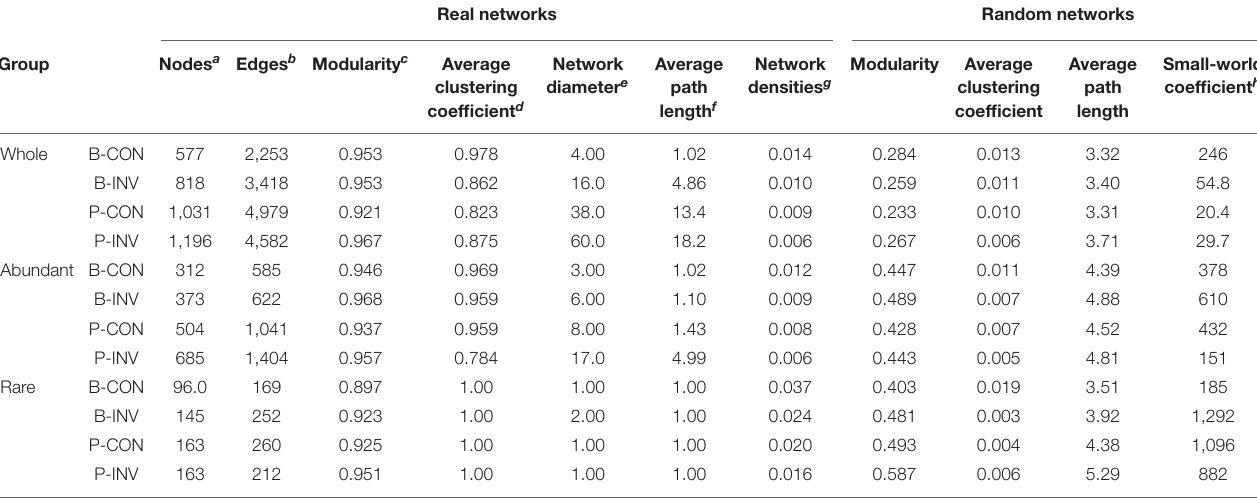
TABLE 1 | Topological properties of the real co-occurrence networks of whole, abundant, and rare communities and their associated random networks. Real